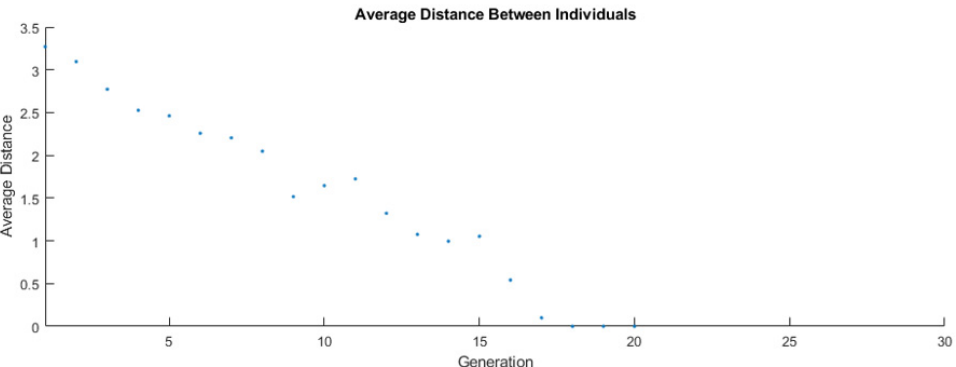
Figure 8. Average distance between individuals for each generation.